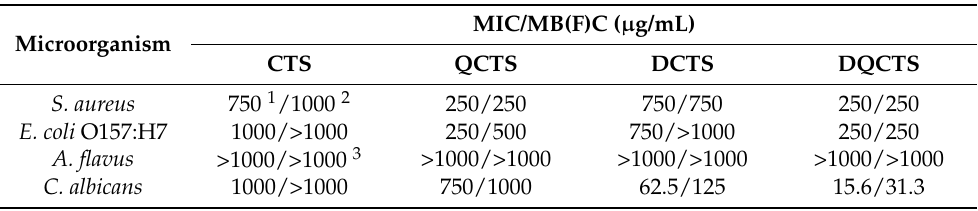
Table 1. Minimum inhibitory concentration (MIC), minimum bactericidal concentration (MBC), and minimum fungicidal concentration (MFC) of various types of chitosan